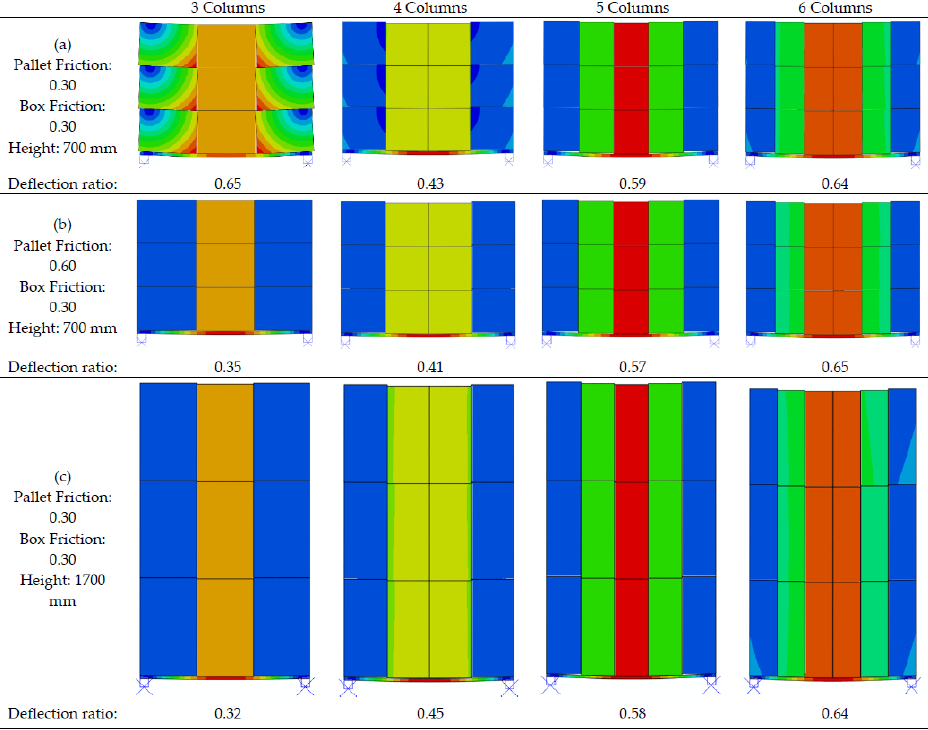
Figure 10. Finite element model simulations for 3, 4, 5, and 6 columns and three combinations of pay- load height and pallet and box friction coefficients. ( a ) Low pallet friction with short payload height; ( b ) high pallet friction with tall payload height; and ( c ) low pallet friction with tall payload height. Colors shown represent displacement (U). Blue equals no movement, red equals large